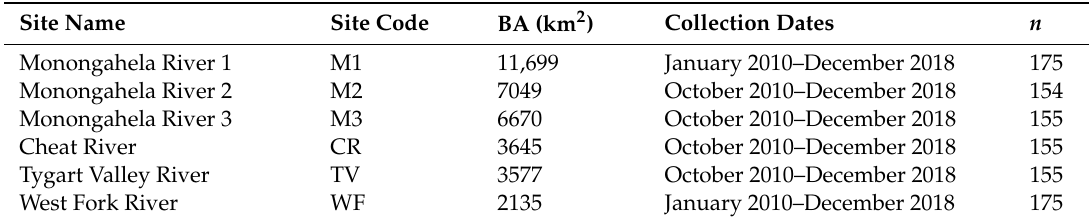
Figure 1. Location of water quality sampling sites (n = 6) and United States Geological Survey (USGS) gauging stations (n = 4) used to characterize and predict spatio-temporal variability in total dissolved solids (TDS) within 8 digit hydrologic unit code (HUC) watersheds comprising the upper Monongahela River basin. Table 1. Basin areas, collection dates (month / year), and number of samples (n; days of data) for the six sample sites. Site codes match those presented in Figure